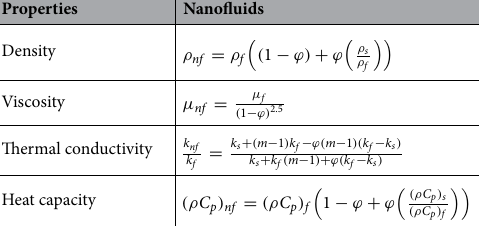
Table 2. The physical expressions of nanofluids.